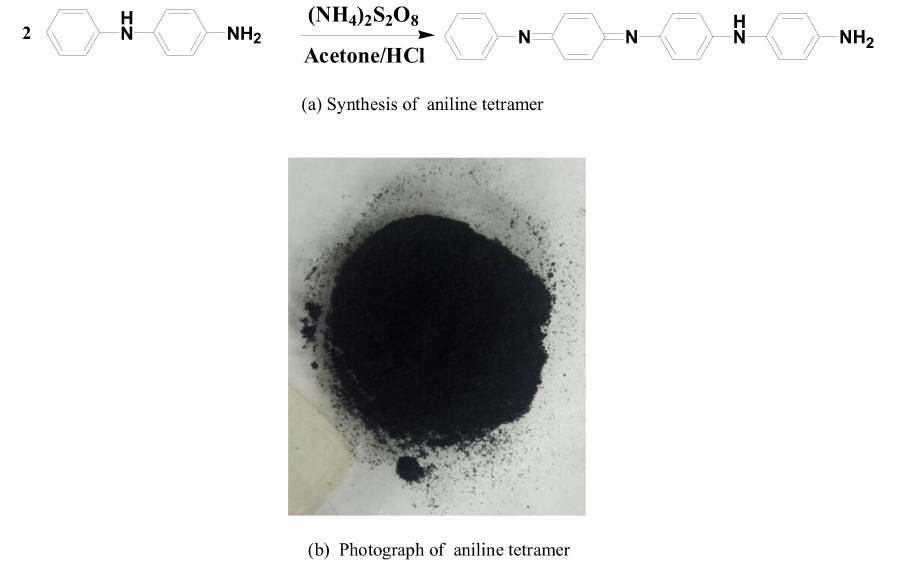
Figure 1. Synthesis ( a ) and photograph ( b ) of aniline